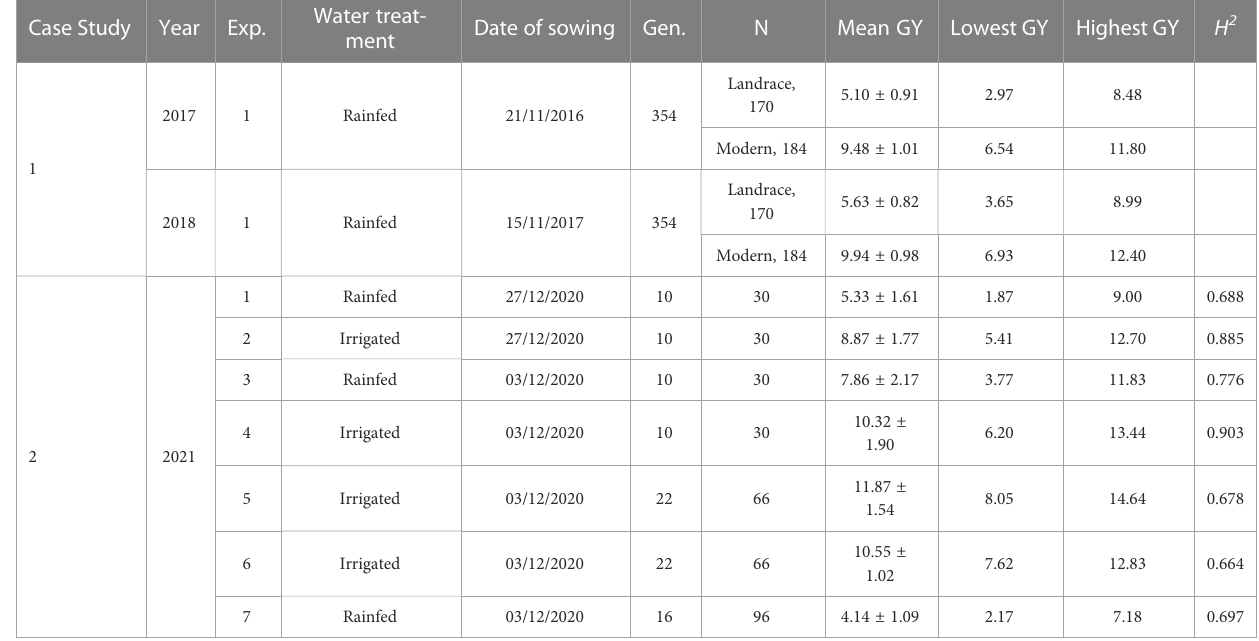
TABLE 1 Grain yield (GY, t ha -1 ) means and standard deviation, number of plots, the minimum and maximum GY, and heritability (calculated only in replicated trials,